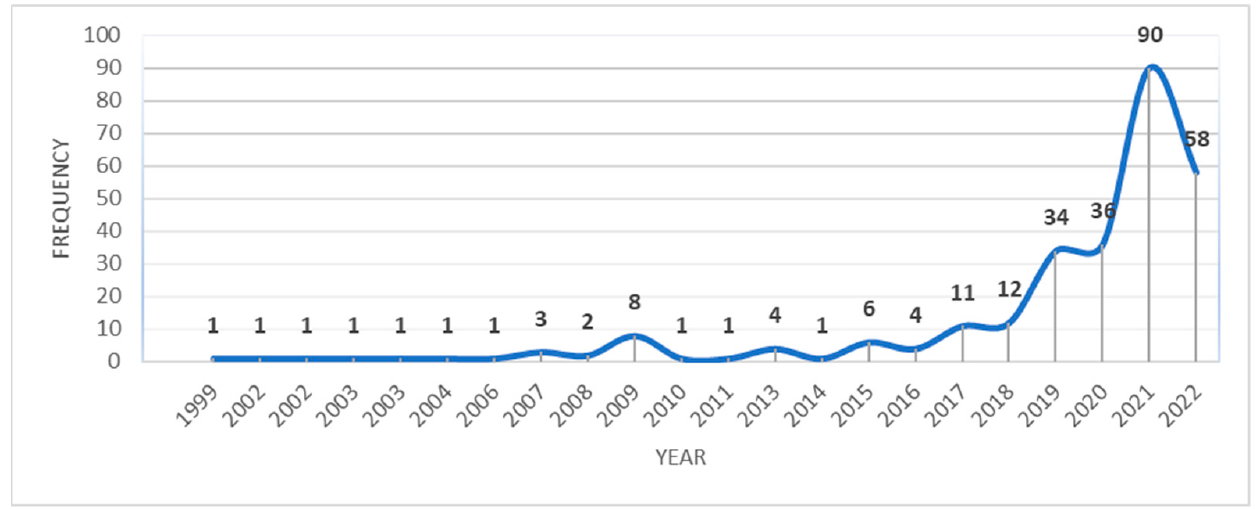
Figure 1. Time trend of AI in online distance education publications.